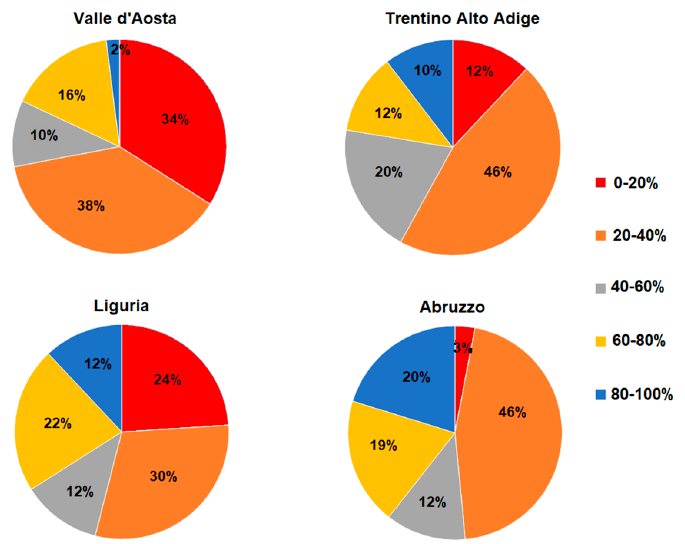
Figure 9. Classification by mechanical accessibility of the low-mechanisability regions.